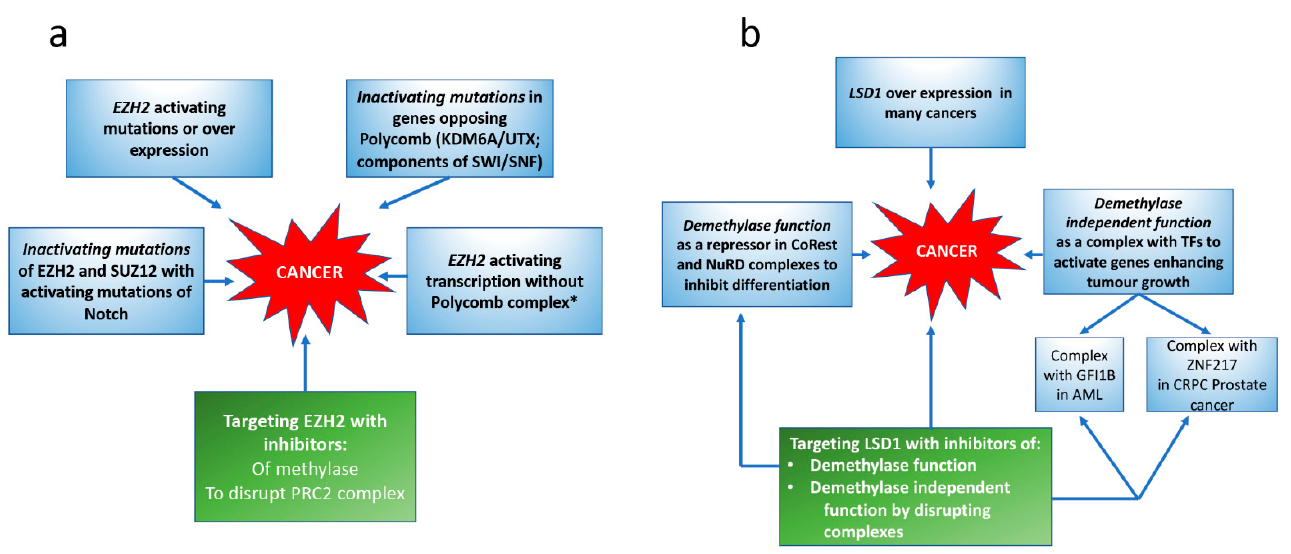
Figure 3. Involvement of EZH2 and LSD1 in cancer and their use as potential therapeutic targets. ( a ) Involvement of EZH2 in cancer. ( b ) Involvement of LSD1 in cancer. Blue boxes indicate the different ways EZH2 or LSD1 are implicated in cancer; green boxes, potential targeting approaches. * Governed by methylase dependent and independent pathways in CRPC.